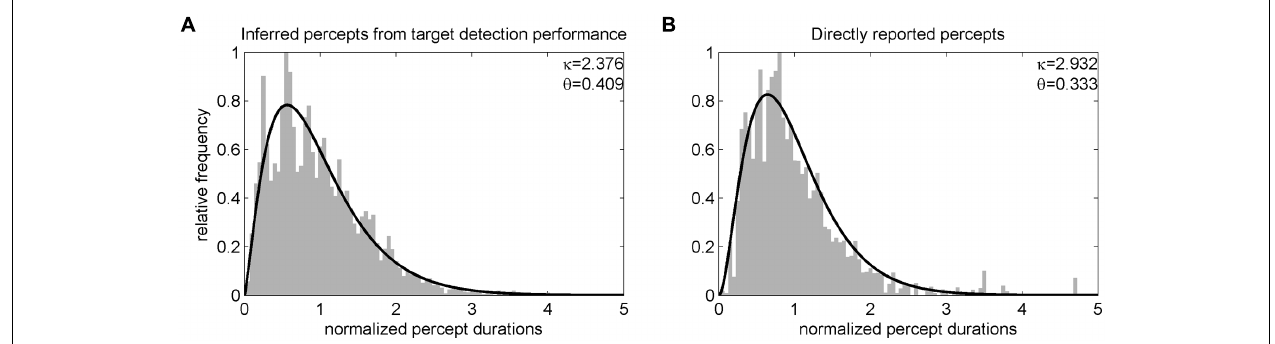
FIGURE 2 | Distribution of normalized percept durations of Experiment 1. Before averaging across participants, individual percepts were normalized, i.e., divided by the corresponding participant’s mean phase duration